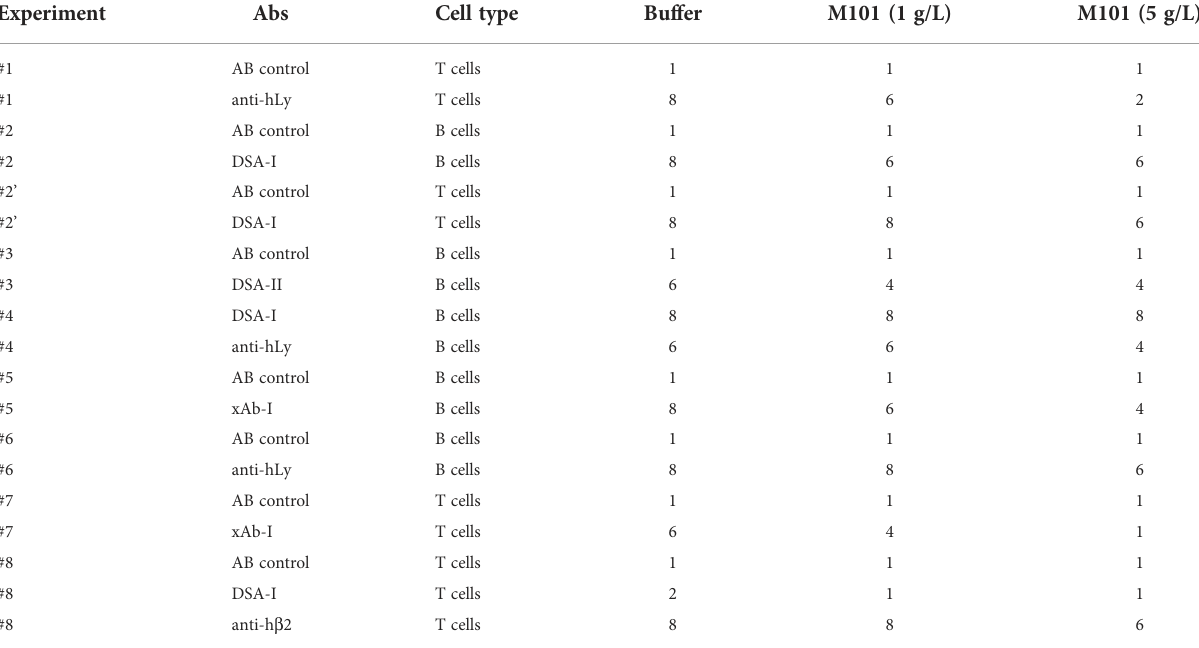
BandTcellswerepuri fi edfromperipheralbloodhumanlivingdonors.Abs,antibodies;ABcontrol,ABhumanserumusedasnegativecontrol;DSA-I,donorspeci fi cAbsanti-HLAclassI; xAb-I, chimeric anti-HLA monoclonal antibody targeting anti-human HLA class I public epitopes (500ng/mL); Anti-h b 2, IgM anti-human b 2 microglobulin; and anti-hLy, IgG anti- human lymphocytes (target unknown).